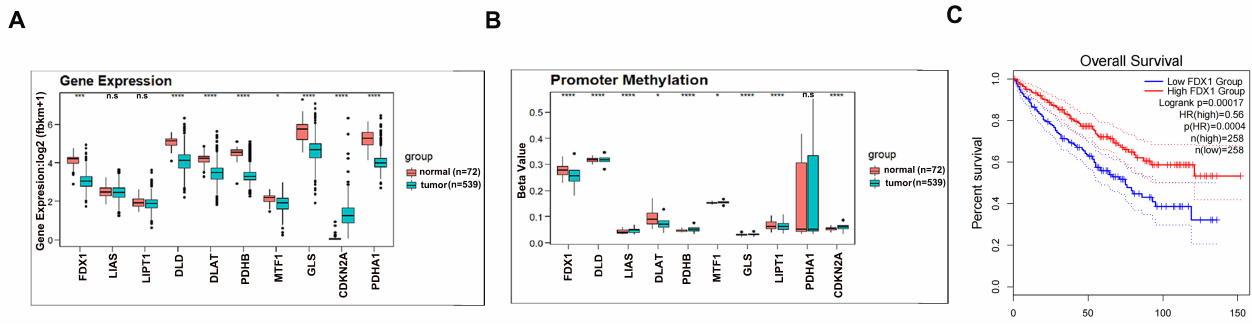
Figure 1. Clinical significance of cuproptosis regulators in ccRCC . ( A ) Expression levels of cuprop- tosis regulators between ccRCC and normal kidney tissues. ( B ) Methylation on promoter regions of cuproptosis regulators between ccRCC and normal kidney tissues. ( C – I ) High expression of FDX1 ( C ), DLAT ( D ), DLD ( E ), PDHB ( F ), LIAS ( G ), LIPT1 ( H ), and PDHA1 ( I ) predicted longer survival in ccRCC according to Kaplan–Meier survival analyses. * p < 0.05, *** p < 0.001, **** p < 0.0001. 3.2. Consensus Clustering Analysis to Evaluate the Potential Role of Cuproptosis in ccRCC To explore the potential role of physiological cuproptosis in ccRCC development, we classified TCGA-KIRC ccRCC patients by conducting consensus clustering analysis using cuproptosis regulators as baits. According to the CDF curve and delta area, k = 2 was chosen as the category number to classify ccRCC patients, which were clearly distin- guished based on the PCA evaluation (Figure 2A–C). A heatmap of the expression pat- terns of cuproptosis regulators in cluster 1 and cluster 2 is displayed in Figure 2D, which indicates that 7 positive cuproptosis regulators were highly enriched in cluster 1, while CKDN2A was enriched in cluster 2. For a convenient description, we refer to cluster 1 as the cuproptosis-sensitive sub-type (CSS) and cluster 2 as the cuproptosis-resistant sub- type (CRS). We then compared the clinicopathological characteristics of CSS and CRS. The data illustrated that CRS ccRCC patients were prone to the risk of having worse clinico- pathological features including the T stage, grade, and metastatic and alive status (Figure 2E). More importantly, CRS ccRCC patients had a shorter overall survival compared to CSS cohorts (Figure 2F, p = 0.00026), implying that physiological cuproptosis benefits pa- tients’ life expectancy.